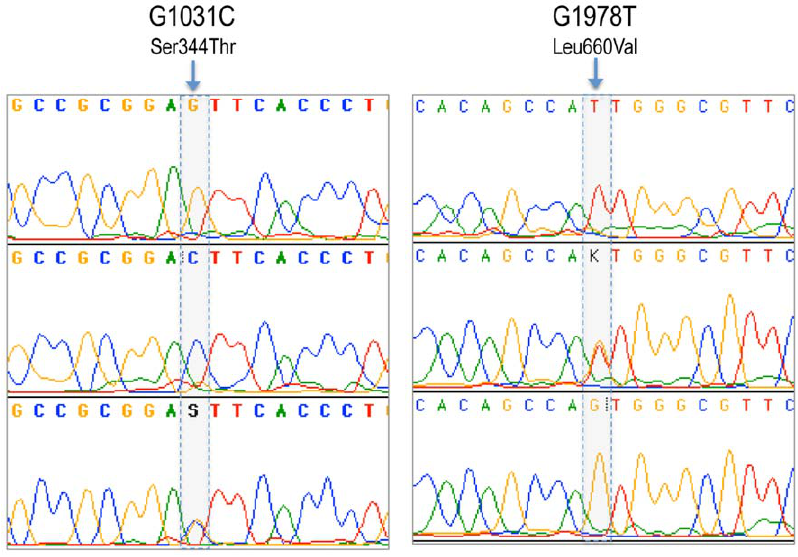
Figure 4. Electropherograms of the two SNPs of hPR gene in exon 1 (G1031C) and exon 4 (G1978T).